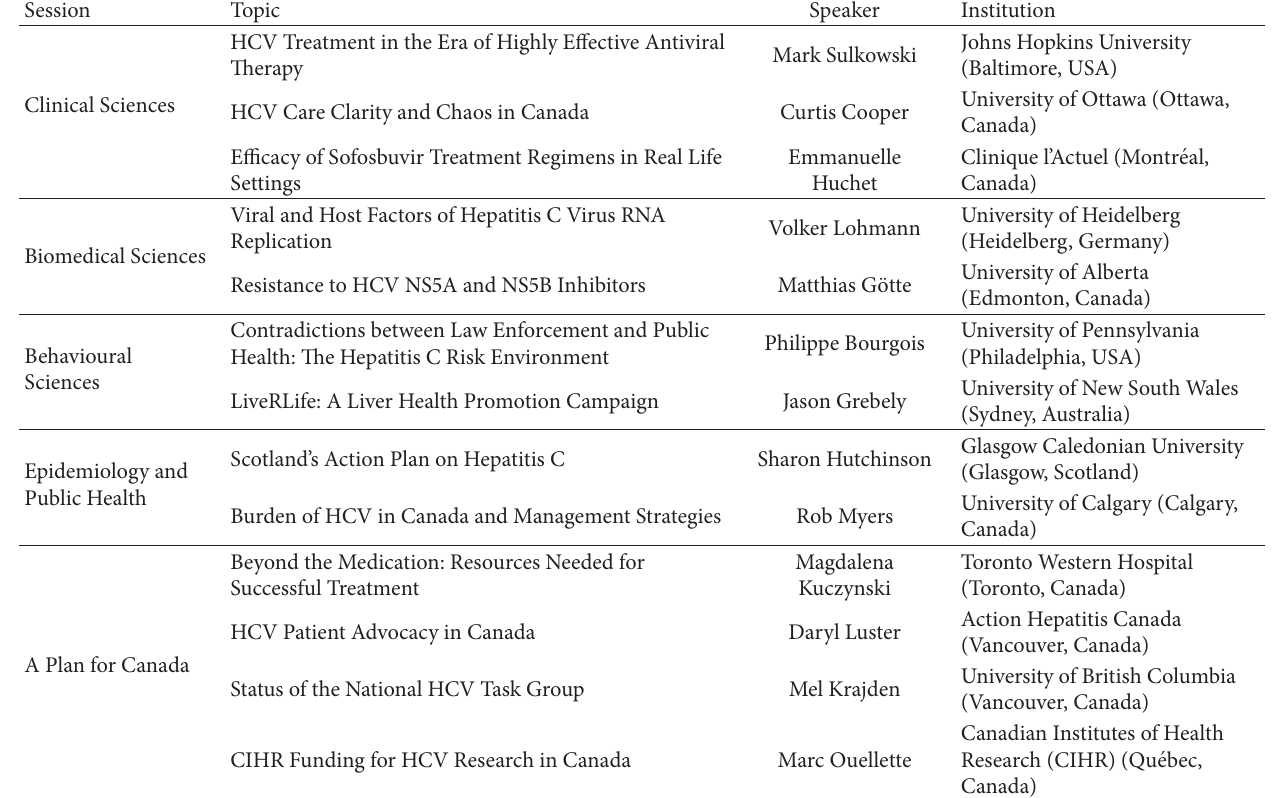
Table 1: Sessions, topics, and speakers for the 4th Canadian Symposium on hepatitis C virus discussed in this